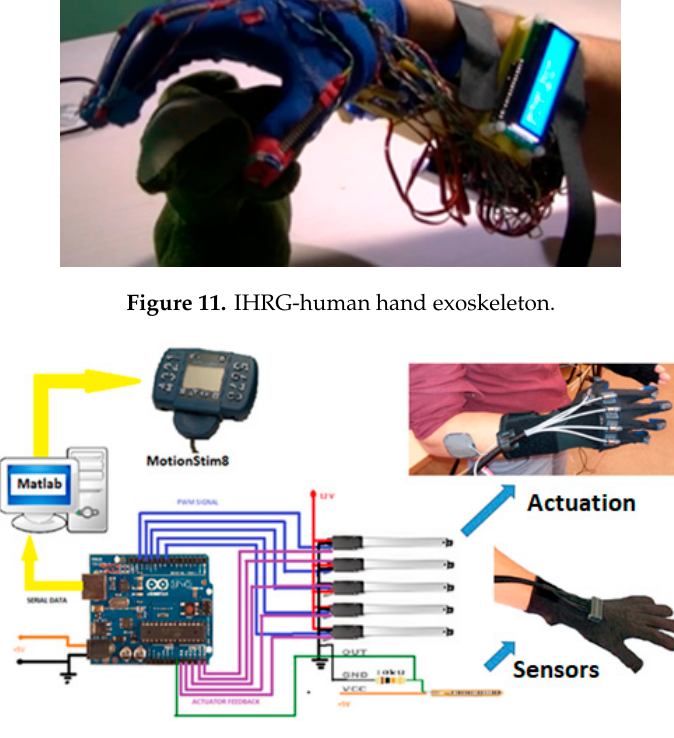
Figure 11. IHRG-human hand exoskeleton.